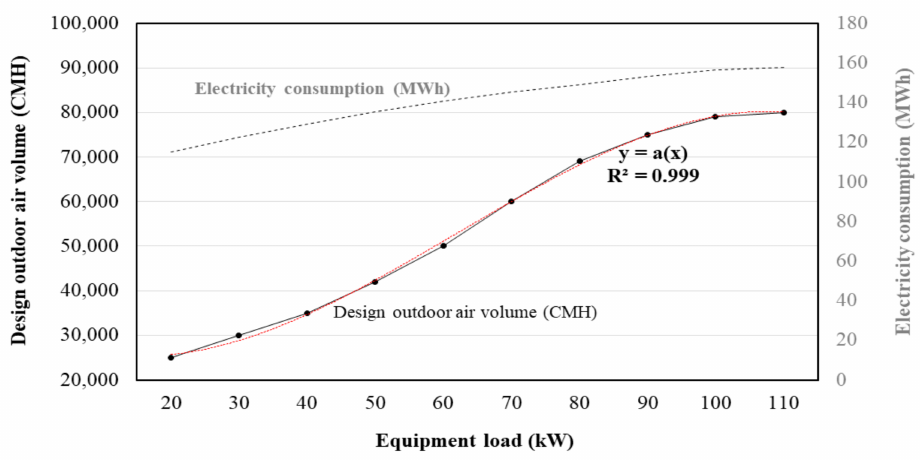
Figure 11. Design outdoor air volume and electricity consumption according to the equipment